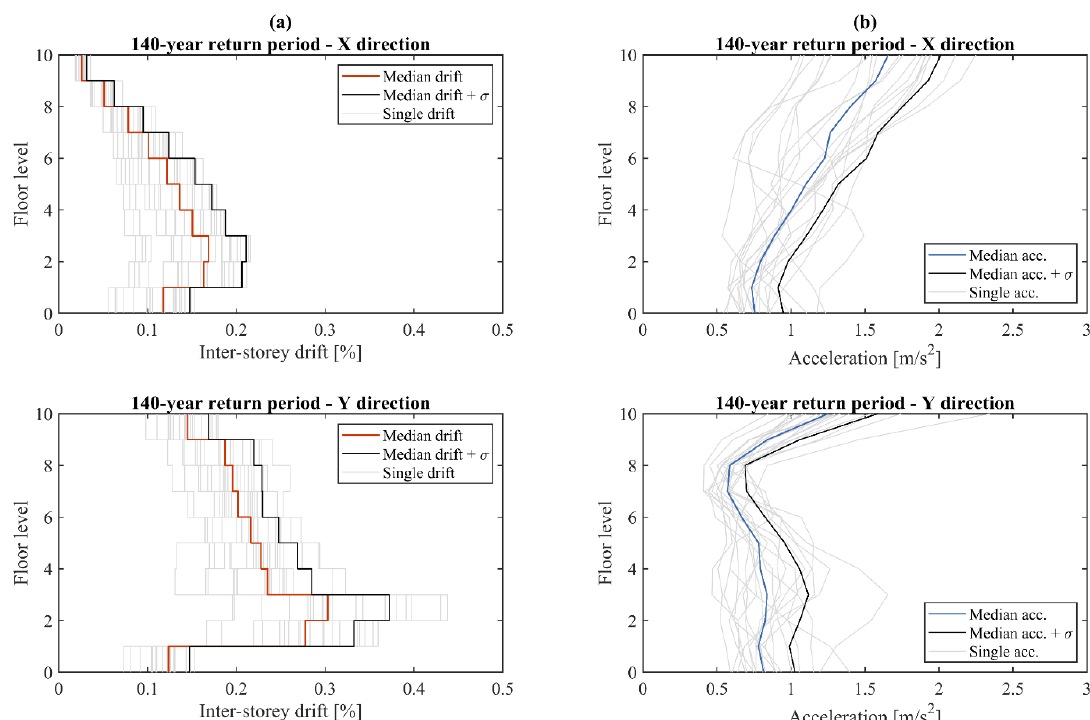
Figure 4. Drift and acceleration peak profiles in longitudinal and transverse directions for RP = 140 years: ( a ) peak storey drifts in X and Y directions; ( b ) peak floor accelerations in X and Y directions.